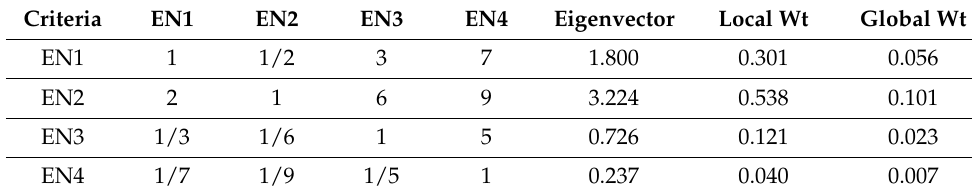
Table A4. Environment subcriteria comparison matrix.